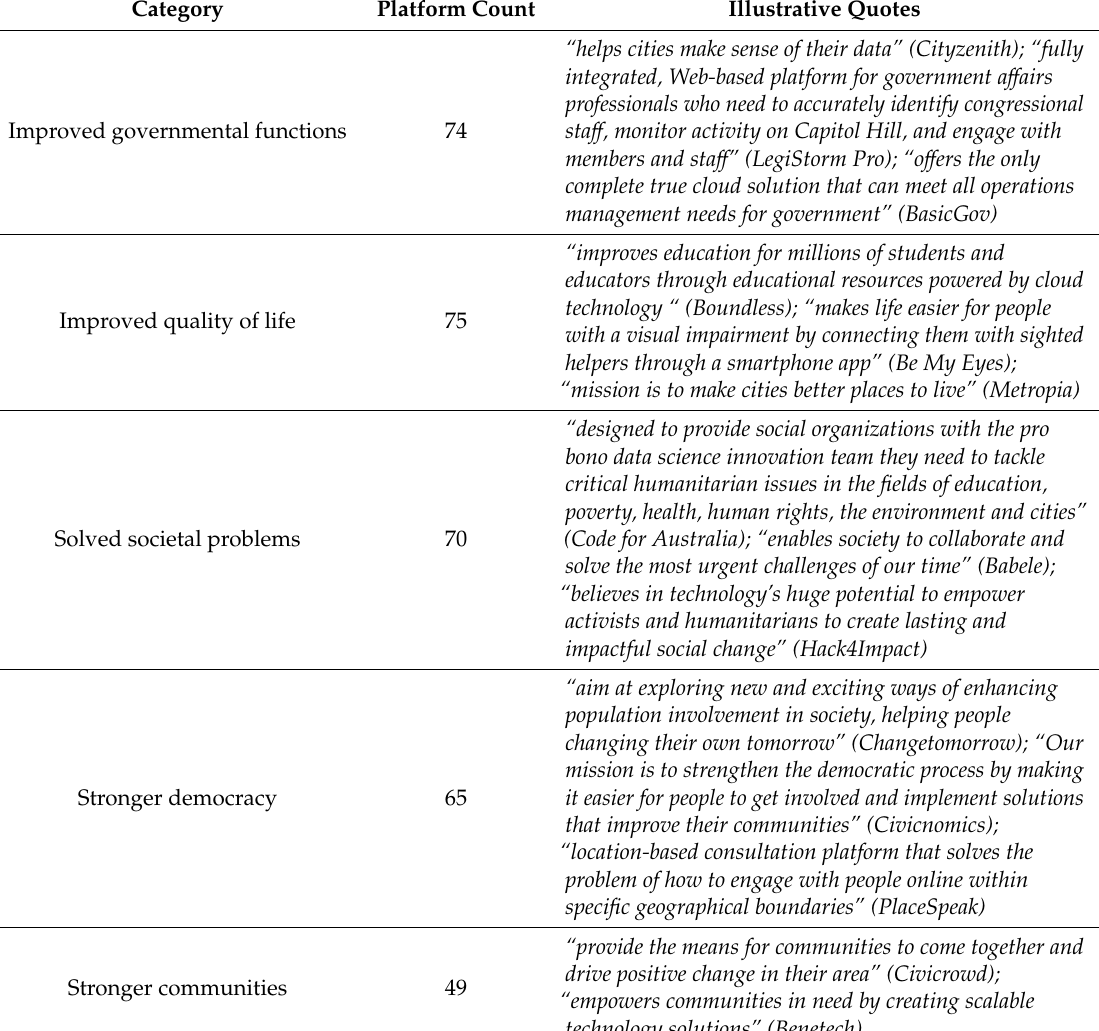
Table 2. Structured Goals of International Civic Technology